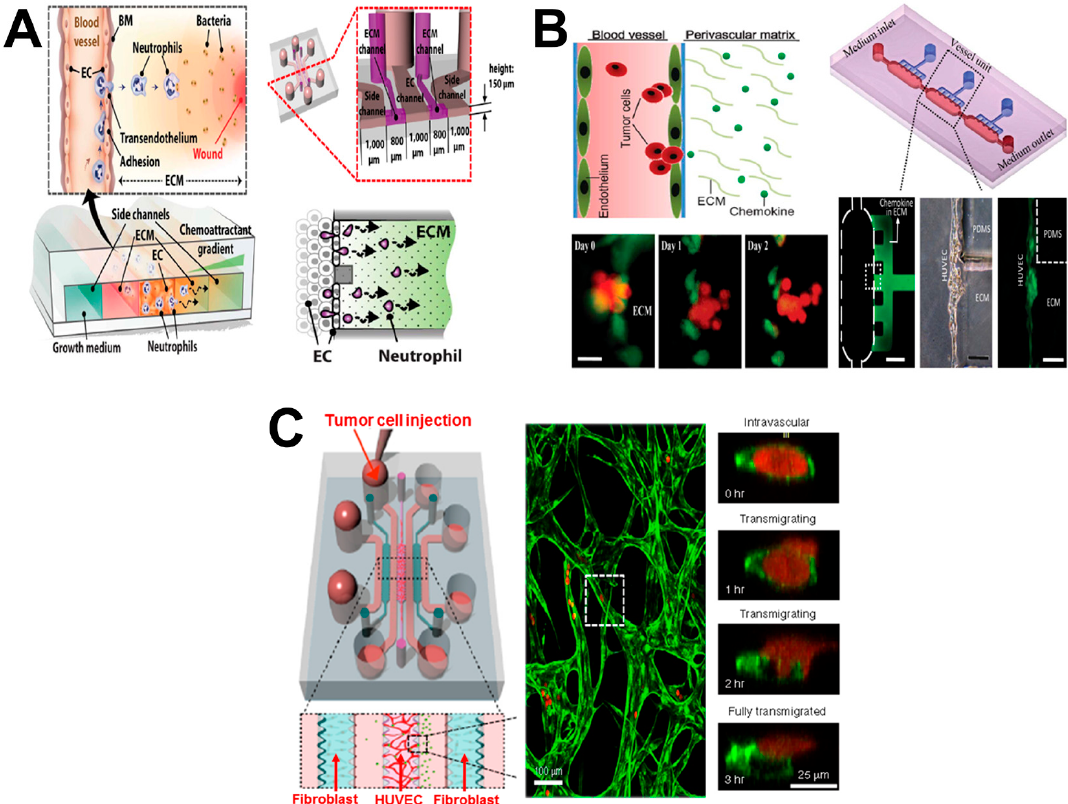
Figure 4. Examples of vessel-on-chip cell migration study. ( A ) The vessel-on-chip model for investigating neutrophil TEM during the inflammatory process. The left panel shows the schematic presentation of neutrophil TEM under inflammatory conditions; the upper-right panel shows the dimensions of the microfluidic device; the bottom-right panel shows the schematic presentation of neutrophil TEM (side view). ( B ) The vessel-on-chip model for investigating tumor TEI. The upper-left panel shows the schematic presentation of tumor TEI; the bottom-left panel shows representative experimental images of tumor cells (red) during TEI; the upper-right panel shows the microfluidic device; the bottom-right panel shows representative experimental images of the selective area. ( C ) The vessel-on-chip model for investigating tumor cell extravasation. The left panel shows the microfluidic device and the detailed information of the selective area; the middle panel shows the magnified view of the selective area (green: microvascular network; red: tumor cells); the right panel shows representative experimental images of one transmigrating tumor cell in the white dashed box. Figure 4A was adapted from reference [35] with permission from the Royal Society of Chemistry; Figure 4B was adapted from reference [42] with permission from the Royal Society of Chemistry; Figure 4C was adapted from reference [43] with permission from Nature Publishing Group. PDMS: polydimethylsiloxane.